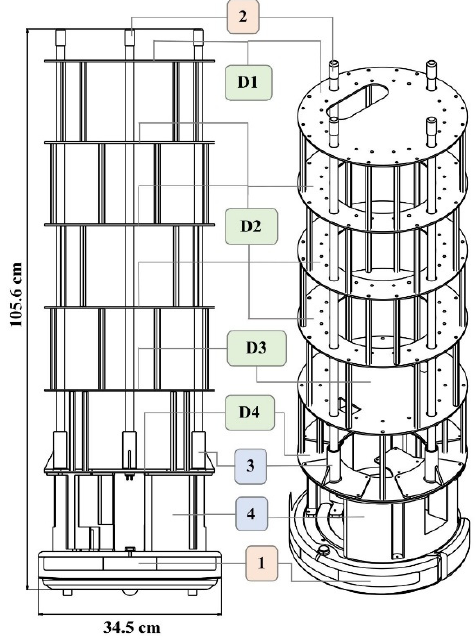
Figure 1. UVBot overall assembly and dimensions. (1) iCreate2 mobile robot, (2) lamps, (3) lamp holder, and (4) base structure. (D1) to (D4) are laser-cut support structures. All components were either purchased off the shelf (salmon-colored boxes), 3D printed in PLA using FDM printing (blue- colored boxes), or laser-cut (green-colored boxes).